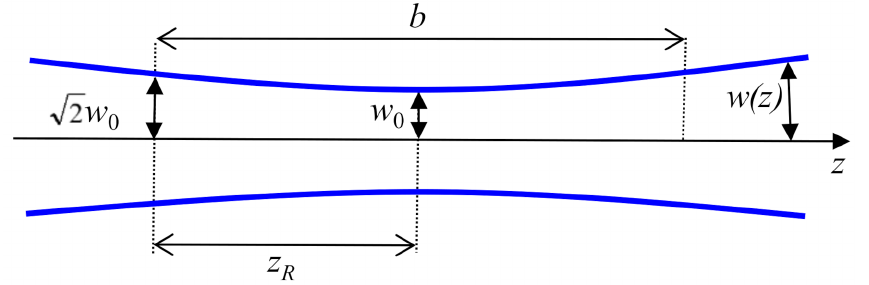
Figure 2. A schematic of the Gaussian beam propagation near the focus of a focusing